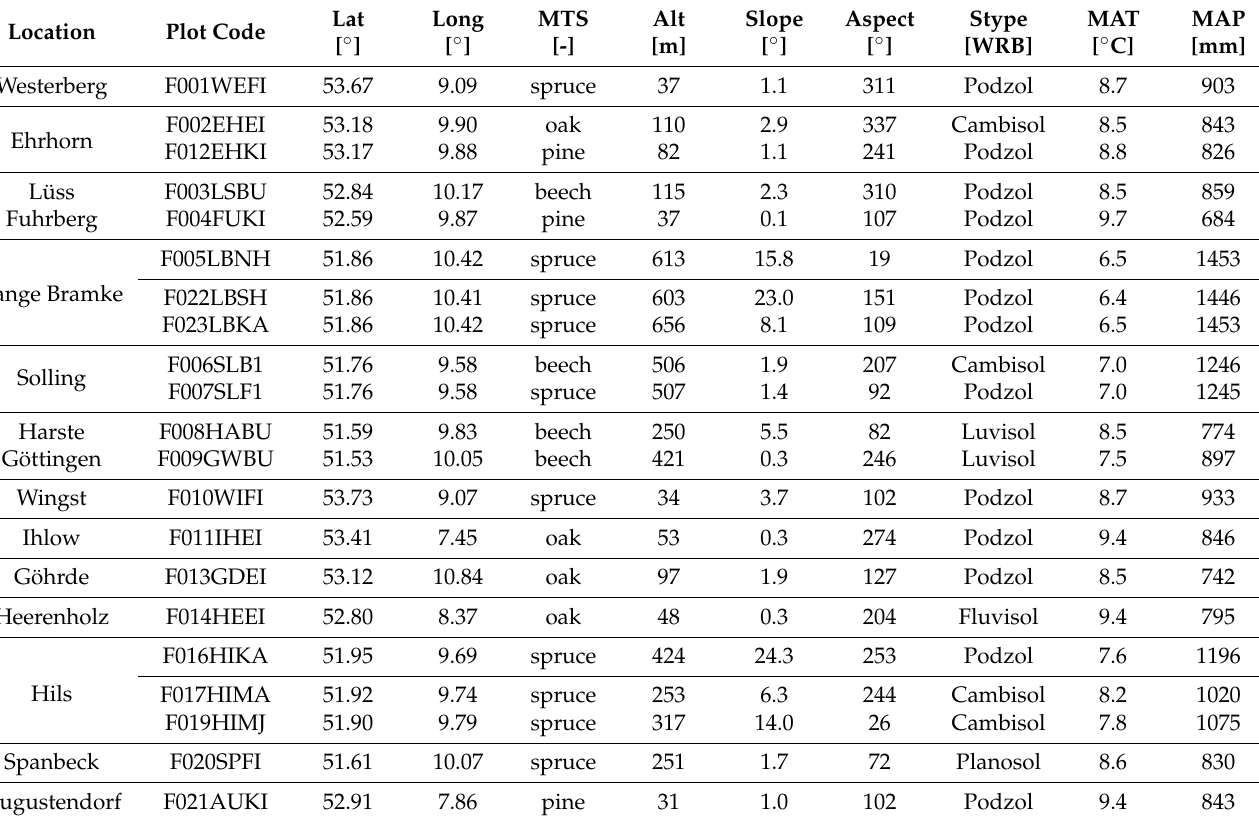
Table 1. Location and plot characteristics for repeated soil-sampling plots in Lower